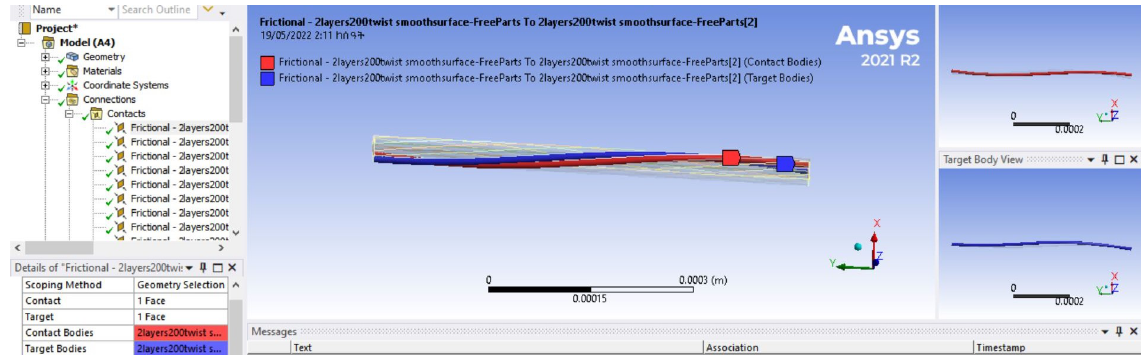
Figure 20. Contact